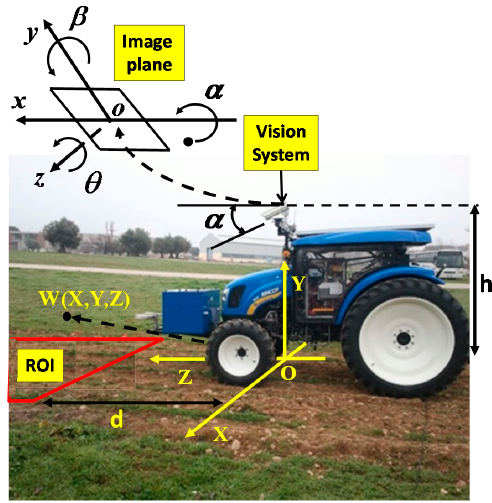
Figure 12. Camera system geometry. Image from [47].